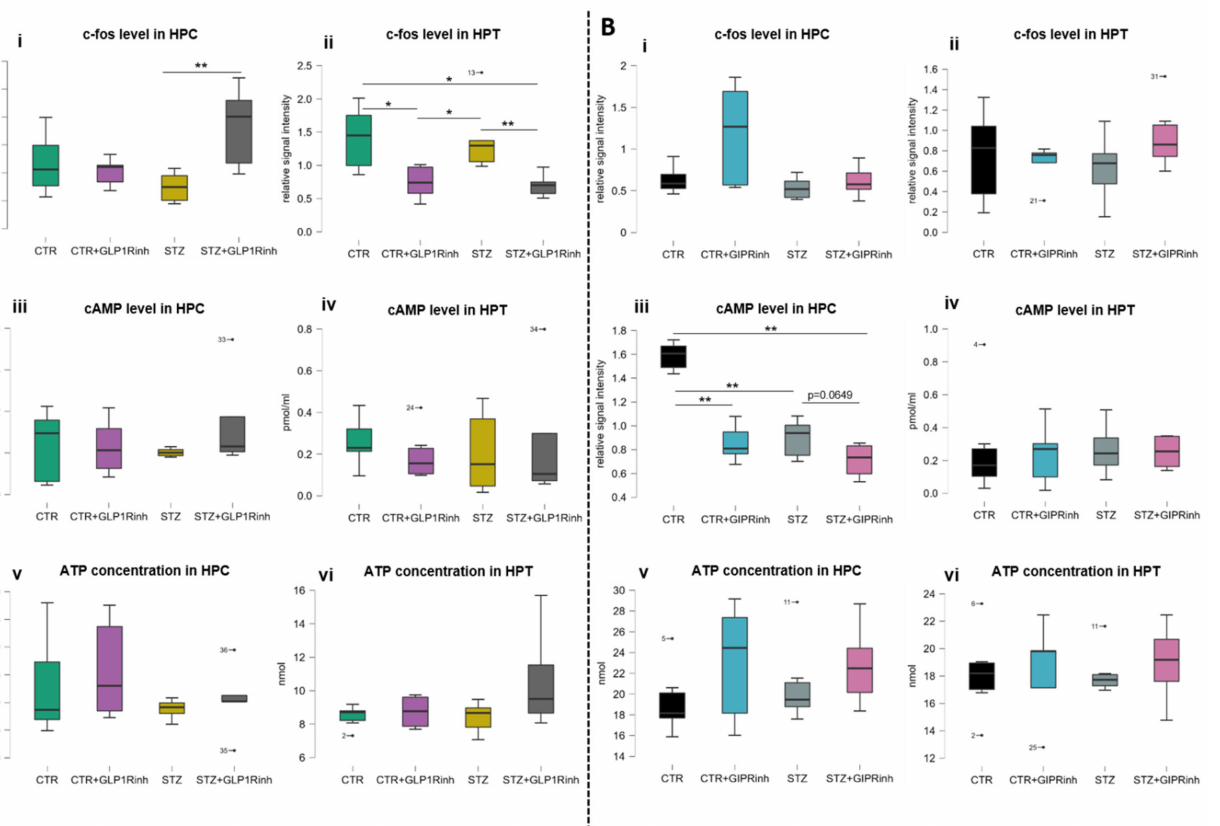
Figure 5. Influence of central glucagon-like peptide-1 and gastric inhibitory polypeptide inhibition on c-fos and cAMP levels and ATP concentration in the hippocampus and hypothalamus. One month after intracerebroventricular (icv) streptozotocin (STZ) or vehicle (CTR) administration, rats were injected icv with 85 µ g/kg of glucagon-like peptide-1 receptor antagonist (exendin fragment 9–39, GLP1Rinh) or 85 µ g/kg of gastric inhibitory polypeptide receptor antagonist (Pro3-GIP, GIPRinh) dissolved in saline or with saline only (CTR and STZ). Animals were sacrificed 30 min after icv administration and the hippocampus (HPC) and hypothalamus (HPT) were dissected, homoge- nized/sonicated, and protein concentration was measured. Neuronal activation, cAMP levels and ATP concentration were measured 30 min after central GLP1R ( A ) and GIPR ( B ) inhibition. Neuronal activation was measured indirectly through c-fos level by Western blot ( i , ii ) inhibition. cAMP levels were measured using a commercial cAMP Direct Immunoassay kit and Western blot analysis ( iii , iv ). ATP concentration was measured by bioluminescence assay ( v , vi ). Values are presented as boxplots with marked outliers and data analyzed by a non-parametric Kruskal–Wallis one-way ANOVA test followed by a Mann–Whitney U test (* p < 0.05; ** p <